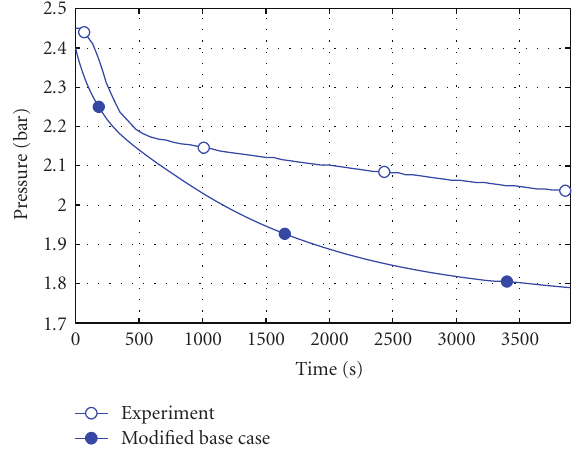
Figure 5: Additional experimental data in part B specification [6].